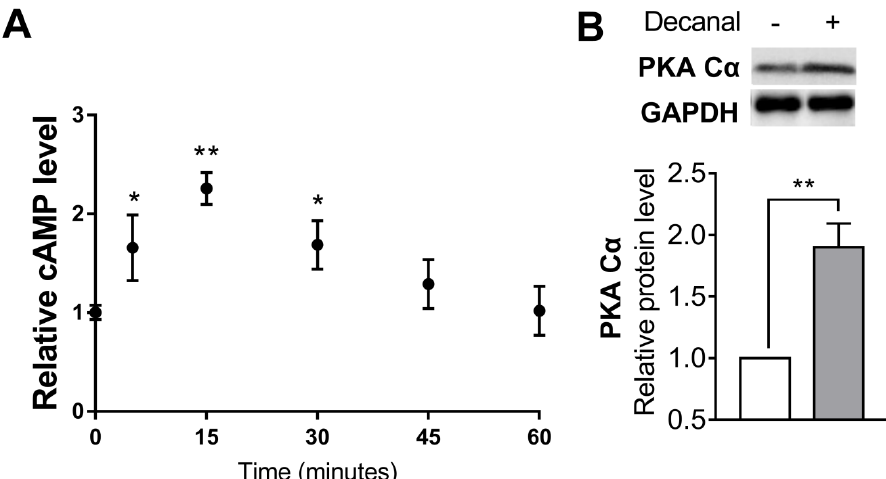
Figure 3. The effect of decanal on the cyclic adenosine monophosphate–protein kinase A (cAMP-PKA) pathway in Hs68 dermal fibroblasts. ( A ) The time course of decanal-induced intracellular cAMP levels was determined after incubation with either the vehicle or 50 μM decanal for 5, 15, 30, 45 and 60 min. ( B ) The protein expression of protein kinase A catalytic subunit (PKA Cα) was measured after incubation with 50 μM decanal for 30 min. Data are shown as the mean ± SEM ( n = 3). Significant differences between decanal and non-stimulated control groups are shown as * p < 0.05; ** p < 0.01.